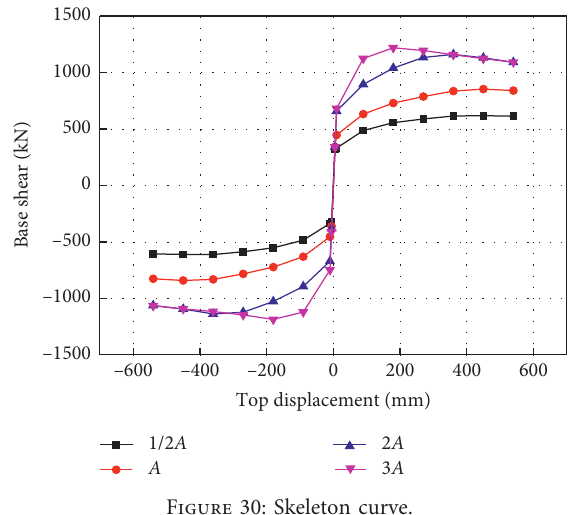
Figure 30: Skeleton